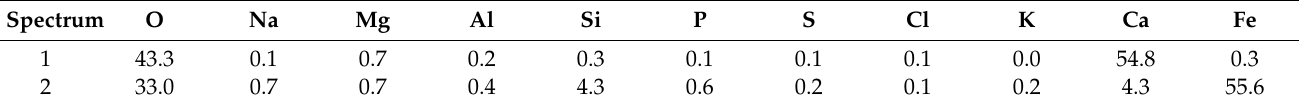
Figure 5. SEM image of sample NS3 showing: ( a ) the replacement of calcite (gray color) by iron rich phases (white color); ( b ) morphological presence of colloid microporous goethite and light gray crystals of lamellar hematite. Red arrows highlight the diffusion front of iron. Points 1 and 2 were analyzed by EDS (see Table 1). Table 1. EDS element analysis (wt%).